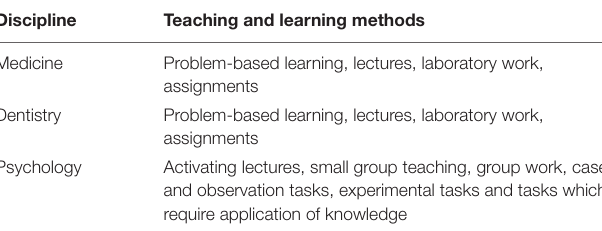
TABLE 1 | Disciplines and used teaching and learning